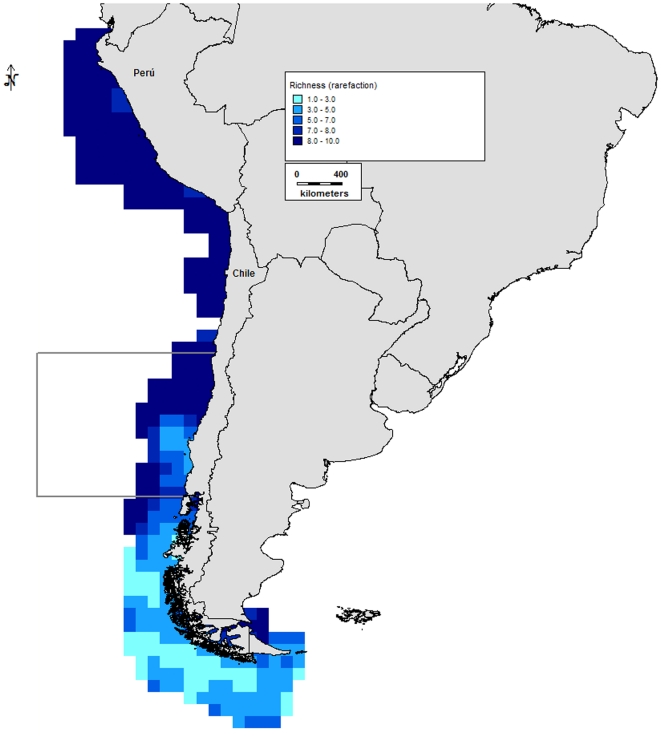
Expected species richness in the Humboldt Current subregion using the
rarefaction technique to estimate the number of species that would have
been observed given a standard number of 10 observations.Scale represents expected number of species.